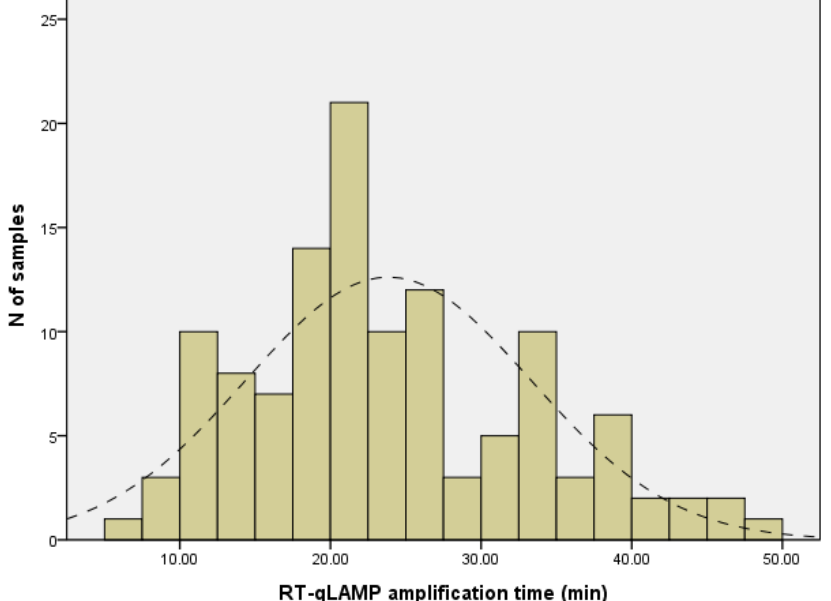
Figure 2. The frequency of amplification time to positivity for RT-qLAMP. The lines of dashes indicate the normal fitted distribution. The mean amplification time to positive results was 22:45 min and